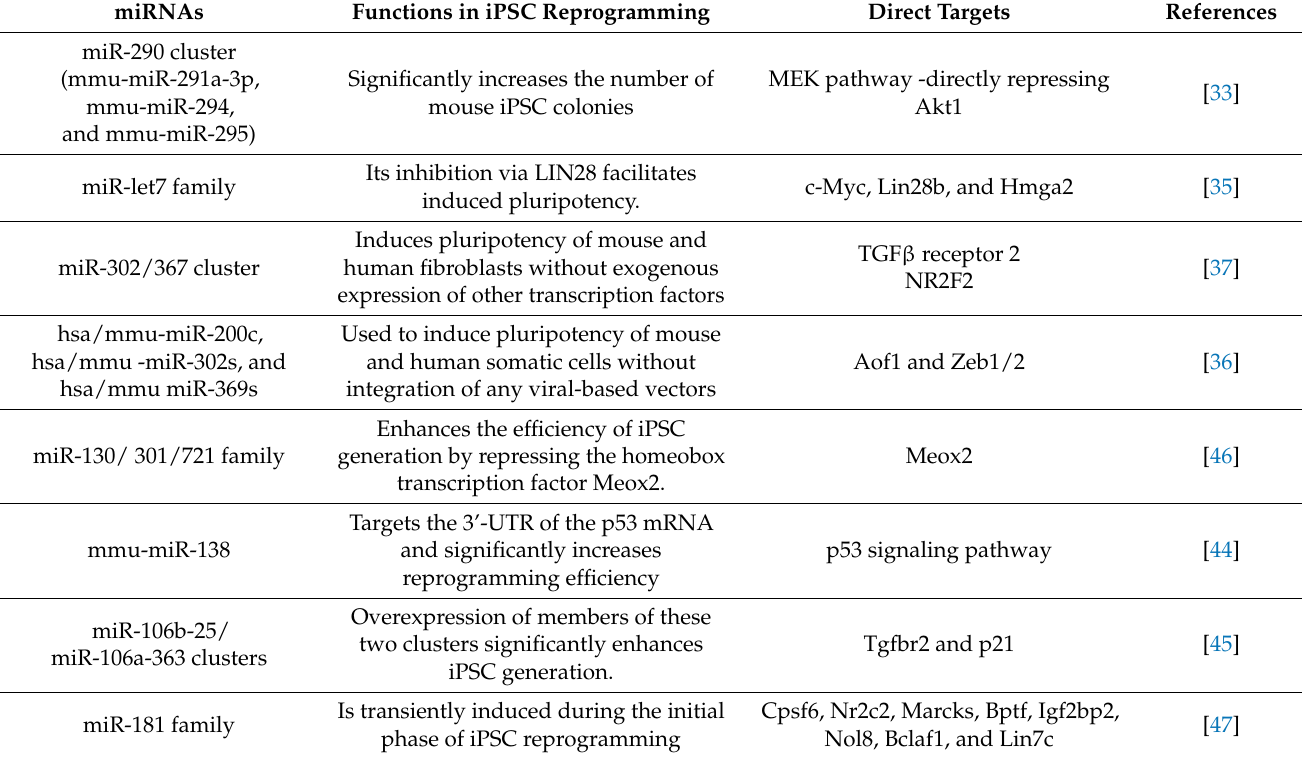
Table 1. Summary of the main miRNAs discussed in the text and their functions in iPSC reprogramming. miRNAs Functions in iPSC Reprogramming Direct